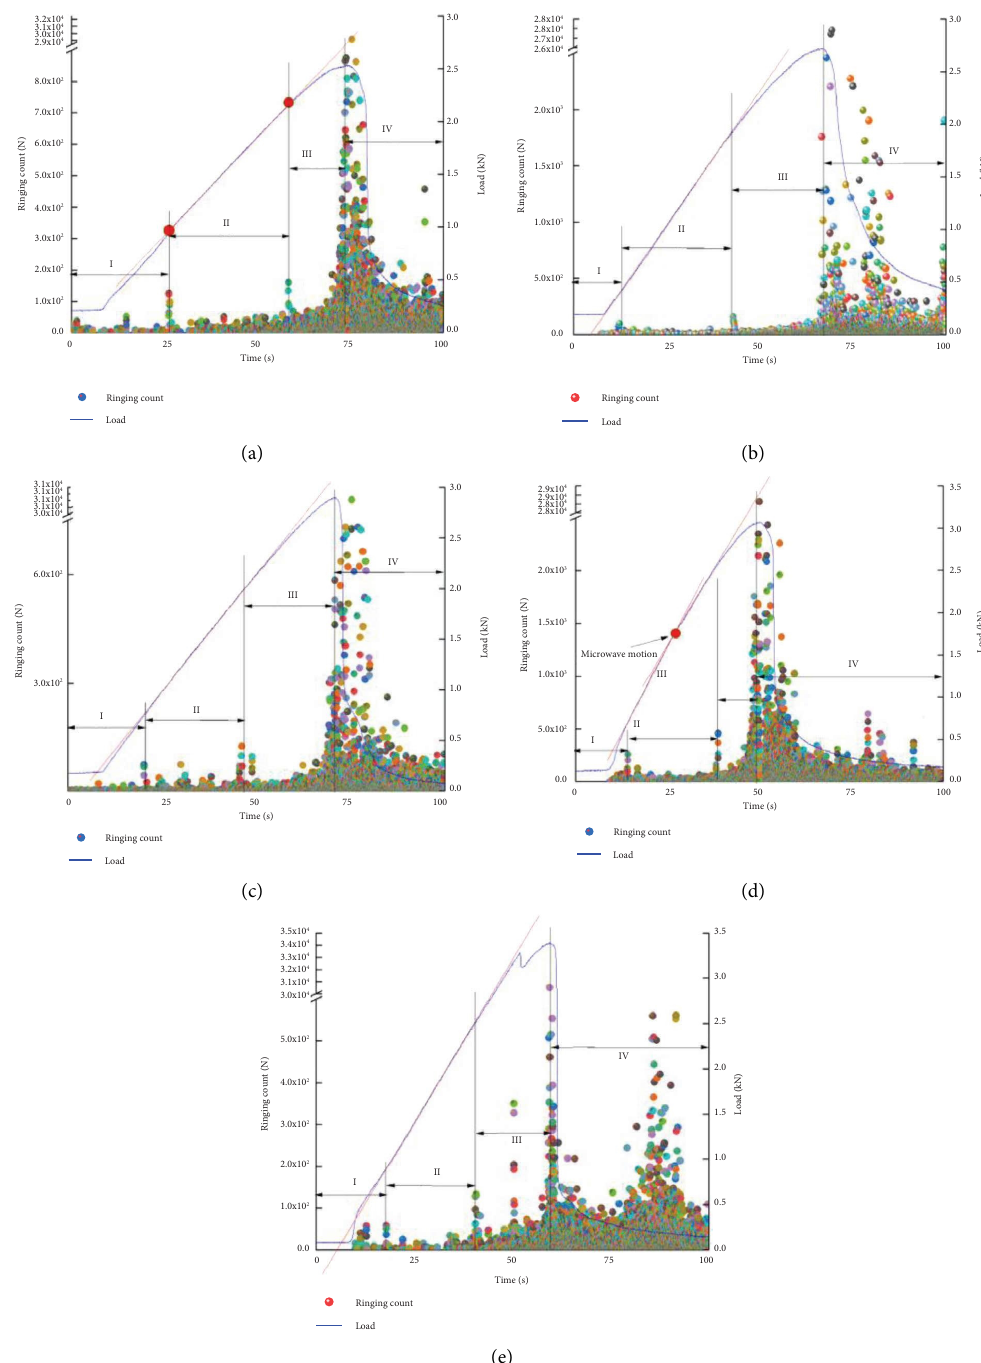
Figure 4: Acoustic emission characteristic parameters and load-time curve of diferent spans: (a) span 180mm, (b) span 170 mm, (c) span 160mm, (d) span 150mm, and (e) span